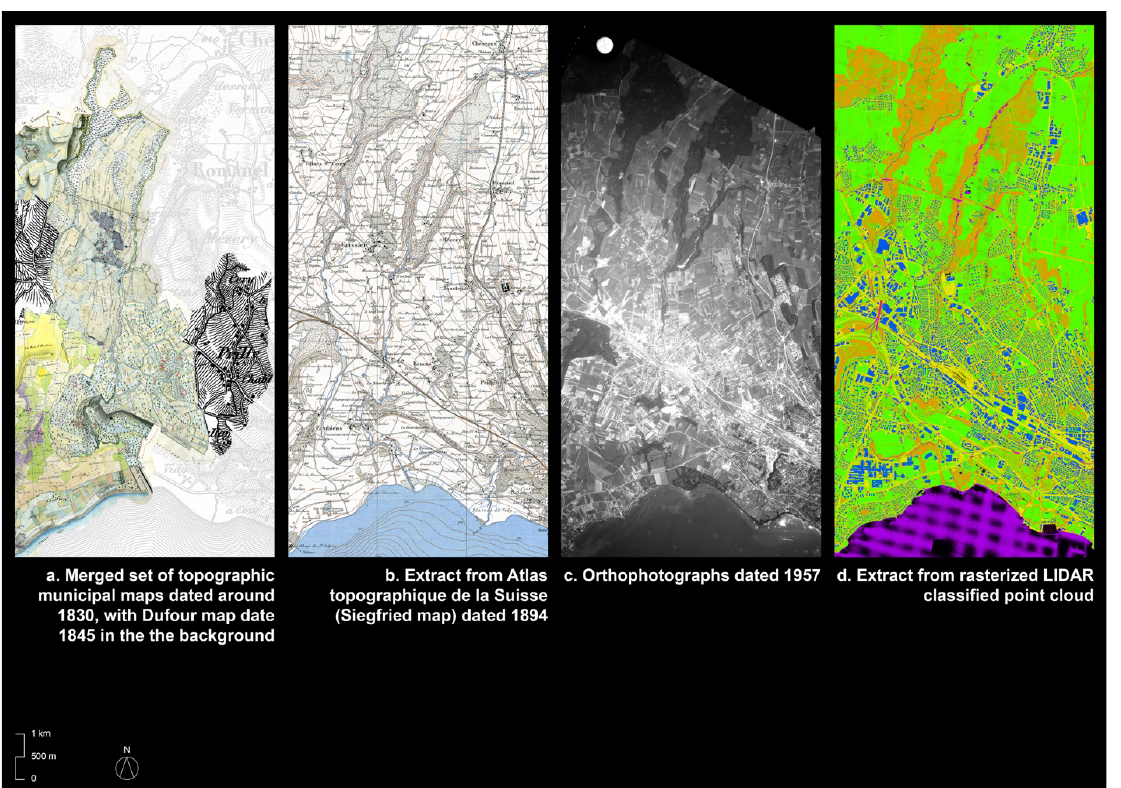
Figure 4. Examples of source documents available through time. Source: Authors, based on geodata and archival sources provided by Archives Cantonales Vaudoises, Swisstopo, and Canton de Vaud–Office de l’information sur le